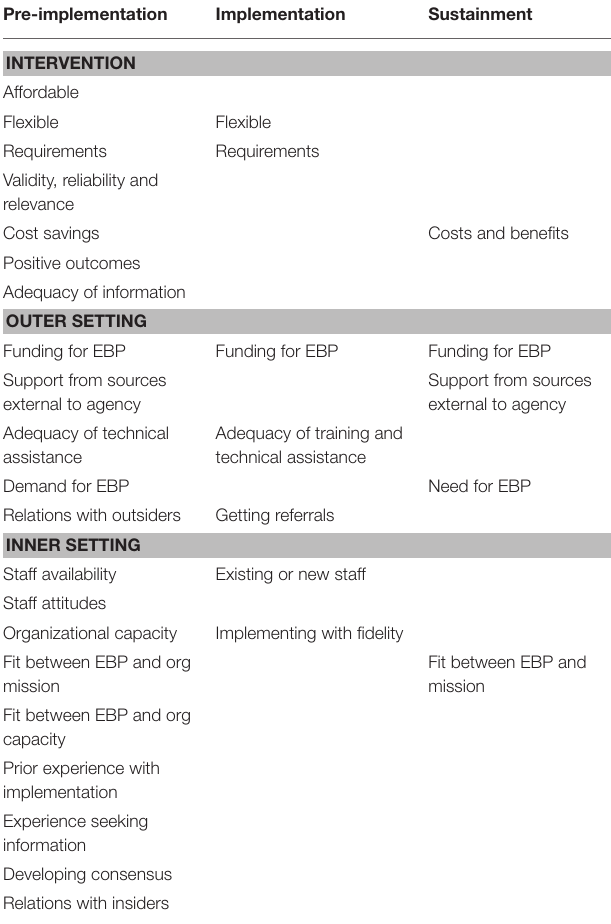
TABLE 1 | Influences on agency leadership assessment of feasibility and